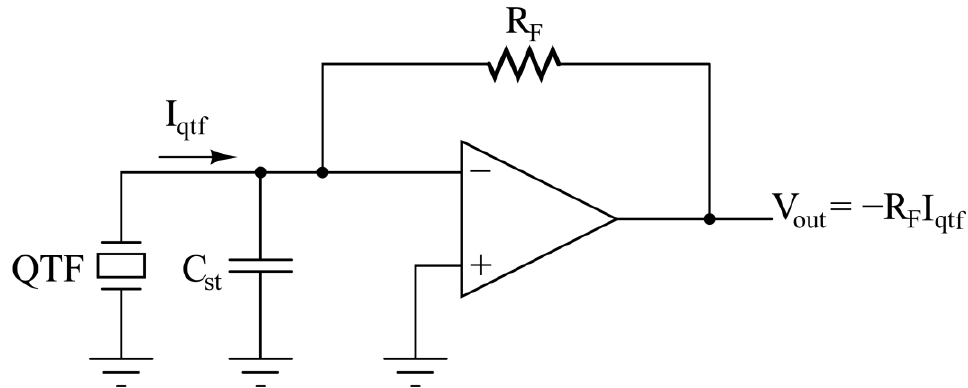
Figure 1. QTF read-out by means of a transimpedance preamplifier.